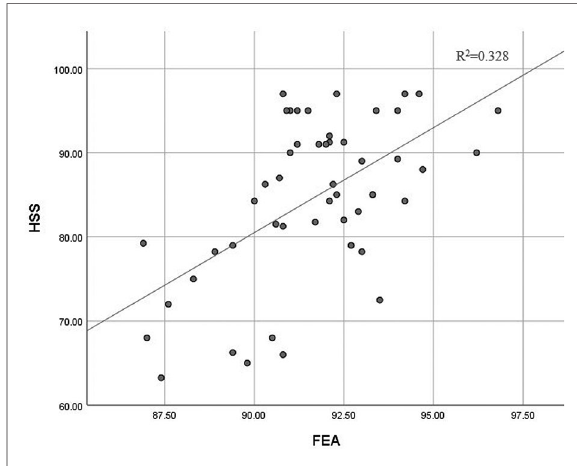
The bold values represents statistically signi fi cant results.